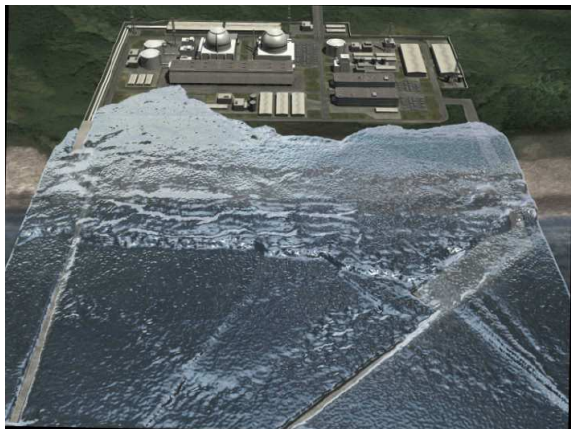
Fig. 2: Tsunami simulation